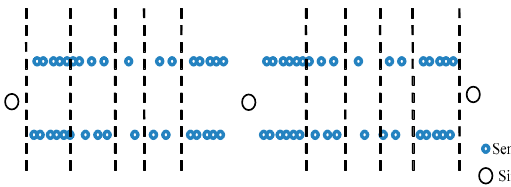
Figure 1. Adiagram of the network topology.